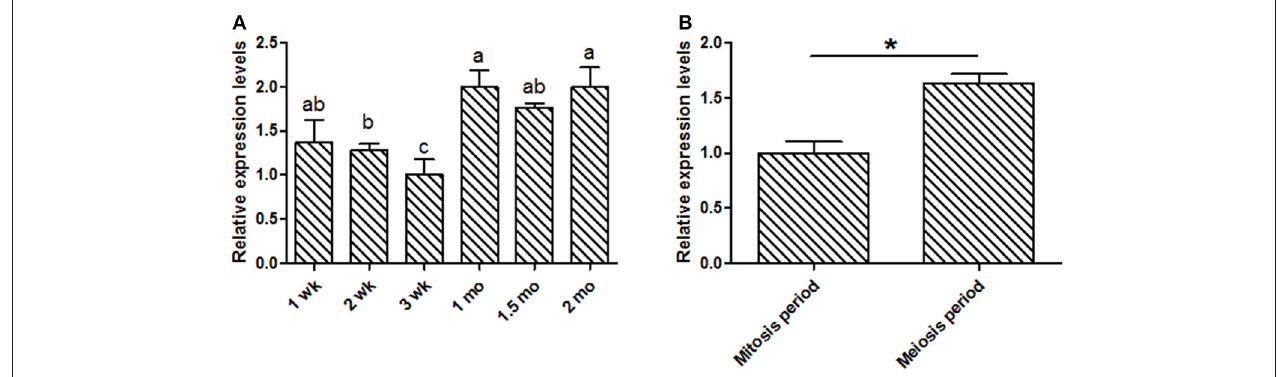
FIGURE 2 | Expression of KDM6A mRNA was detected in goat testes tissues by qPCR. (A) KDM6A mRNA expression profiles at different stages in testis tissue. (B) Expression of KDM6A mRNA at mitosis and meiosis period in testis tissue. Data represent means ± SE ( n = three samples per group). Columns with different letters (a, b) means P < 0.05; * P < 0.05.